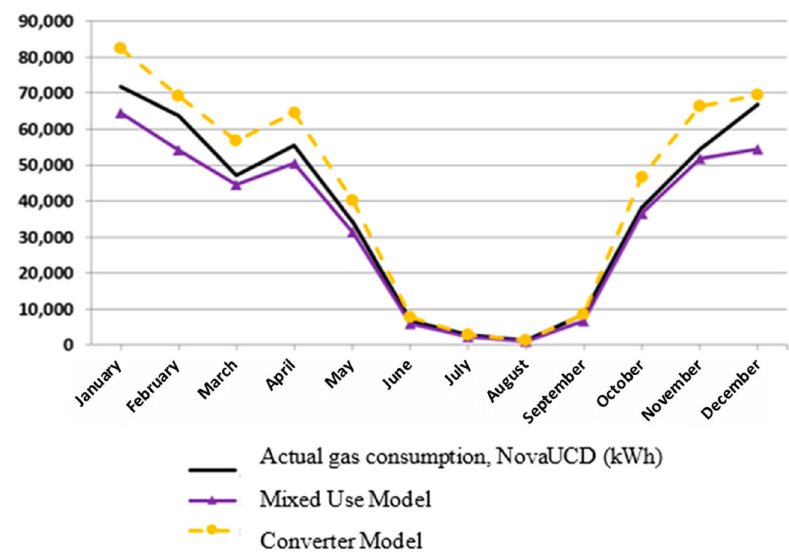
Figure 6. Monthly thermal demand profiles, mixed-use model and converter model, Nova Building, University College Dublin (UCD). Table 6. Recorded data and monthly profiles and percent of errors compared with mean annual of CIBSE for the Nova Building,